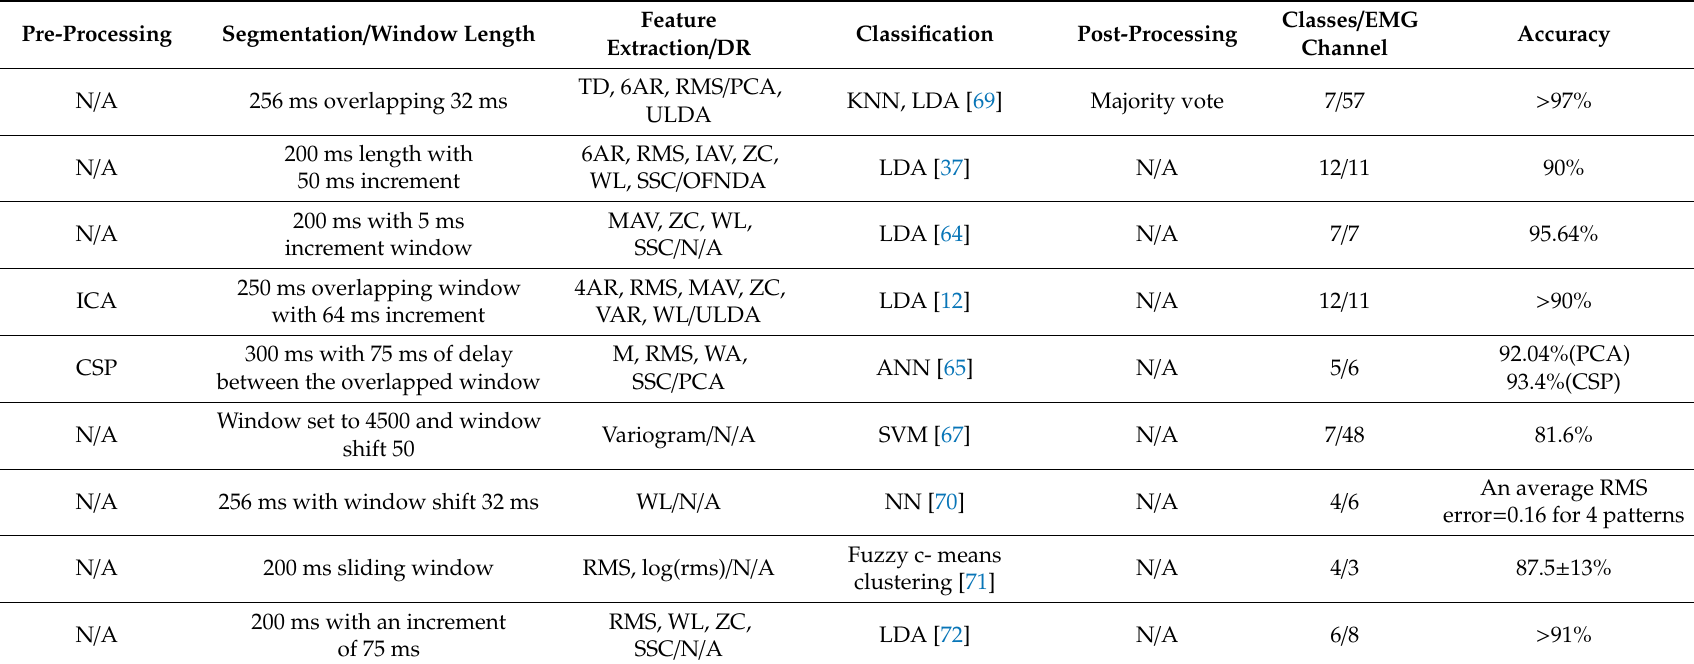
Table 1. Summary of various individual classifiers and combined classifiers tested on amputee data 1